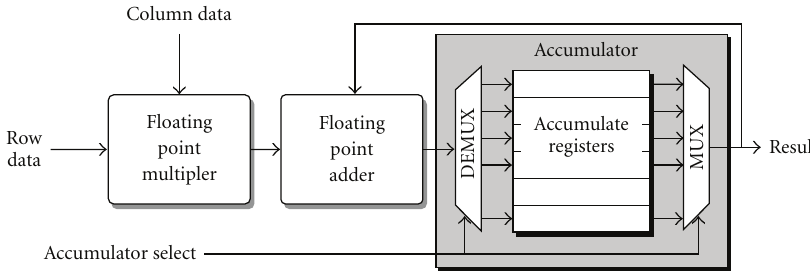
Figure 12: Single precision multiply accumulate